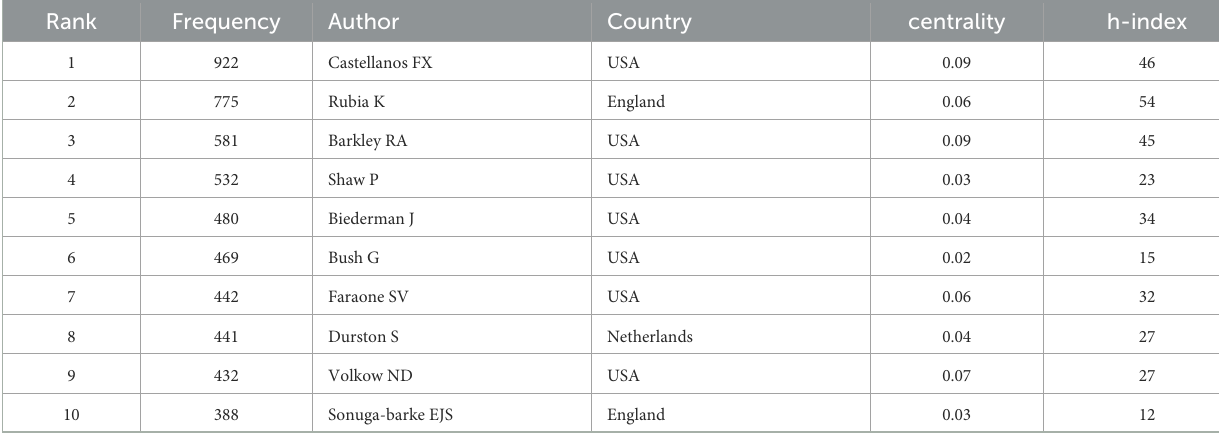
TABLE 4 Top 10 frequency cited authors related to ADHD neuroimaging.